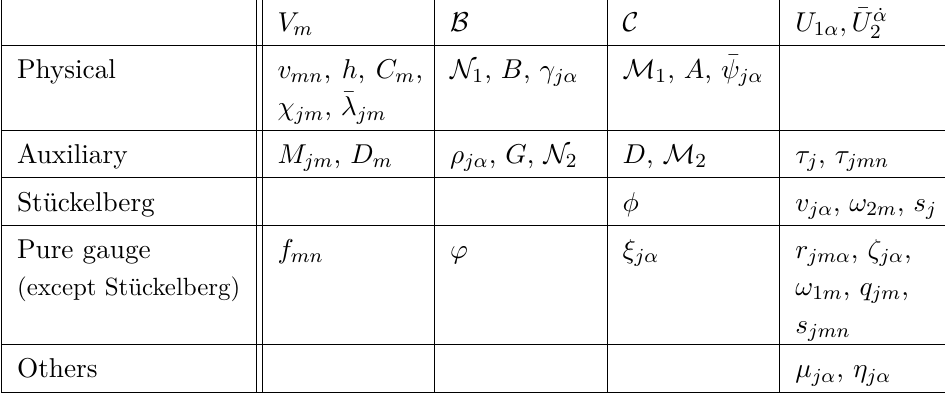
Table 1 . The role of the different auxiliary